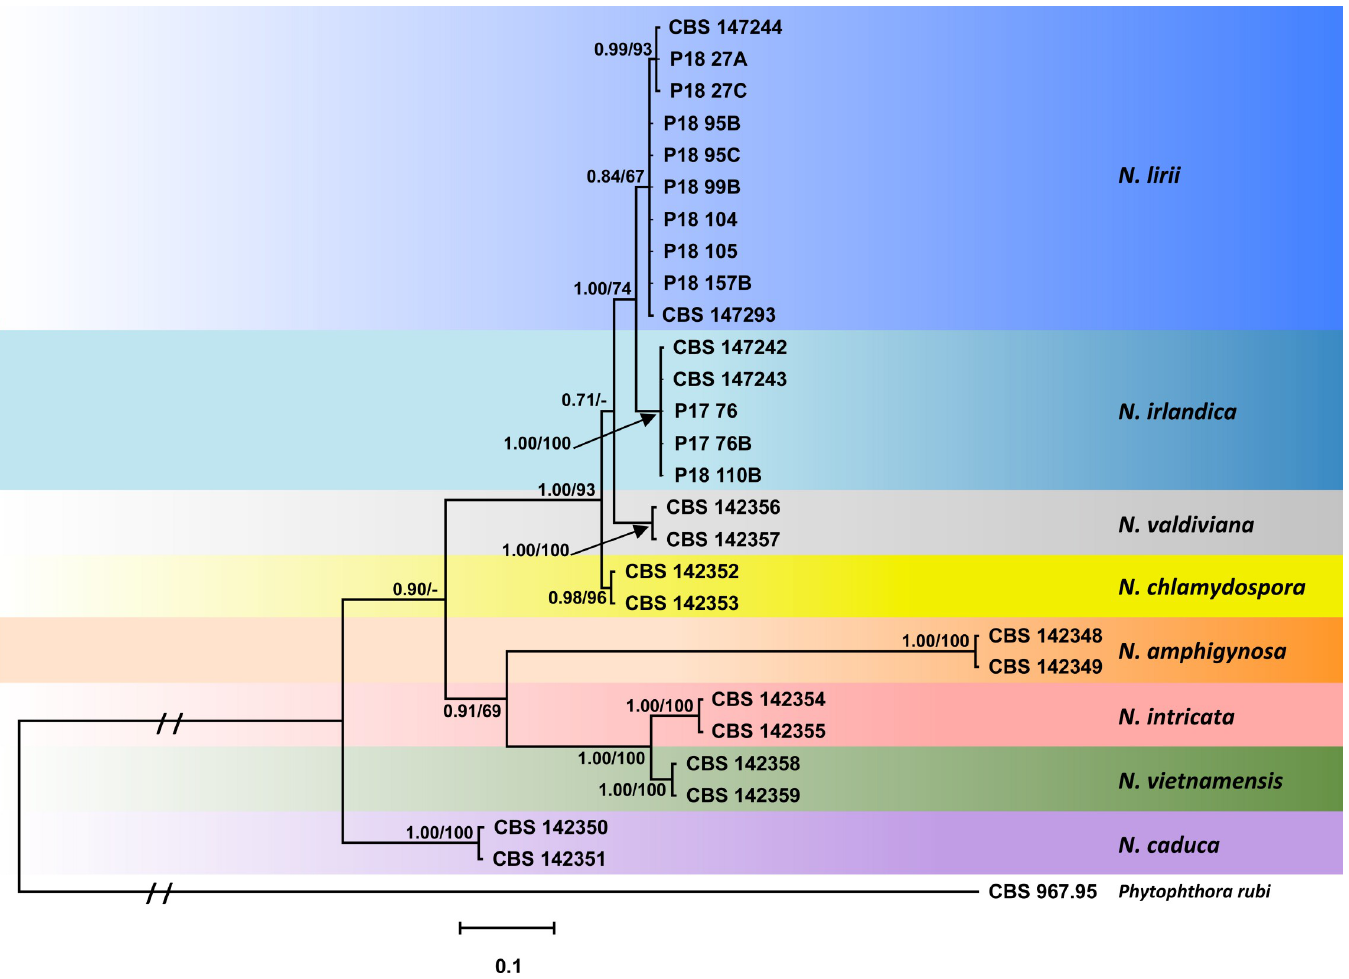
Fig 2. Fifty percent majority rule consensus phylogram derived from Bayesian phylogenetic analysis of nuclear 5-loci (LSU, ITS, btub , hsp90 , tigA ) dataset of Nothophytophthora irlandica and N . lirii sp. nov. and six known Nothophytophthora species. Bayesian posterior probabilities (left) and Maximum Likelihood bootstrap values (right; in %) are indicated, but not shown below 0.7 and 60%, respectively. Phytophthora rubi was used as outgroup taxon. Scale bar indicates 0.1 expected changes per site per